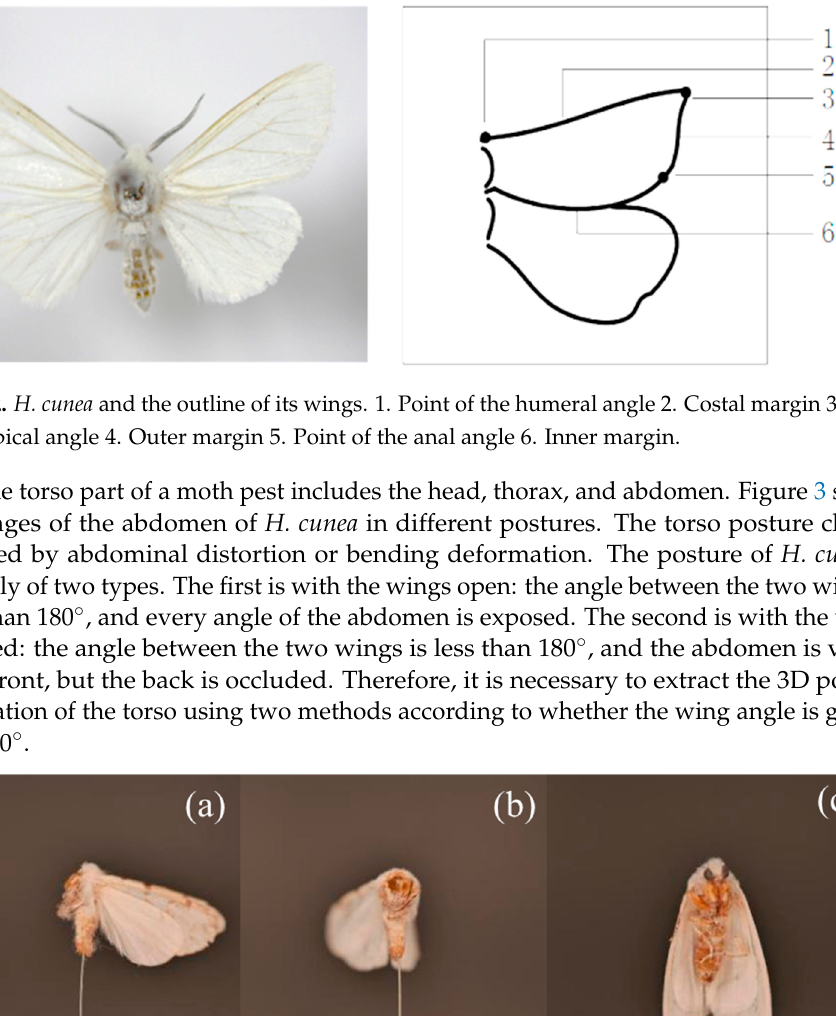
Figure 1. Samples of H. cunea in various poses. Different postures of wings ( left ), and different pos- tures of torso ( right ).